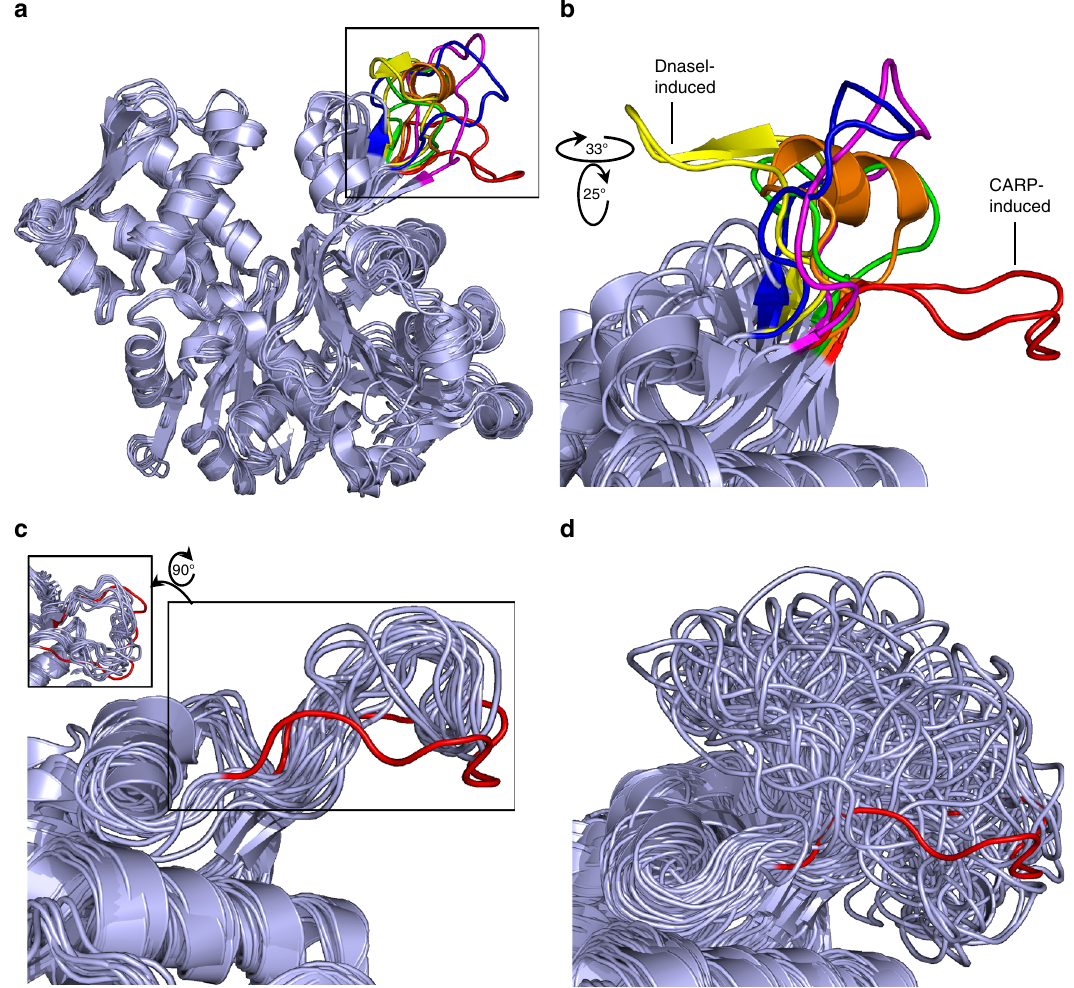
Fig. 2 The D-loop of the G-actin adopts a unique conformation induced by the CARP domain. a Superimposition of selected structures of actin where the D-loop is resolved: un-complexed ADP-actin (1j6z) 48 (orange); ADP-actin in complex with CARP domain (6fm2) (red); ATP-actin in complex with DnaseI (3w3d) 49 (yellow); ATP-actin in complex with pro fi lin (2btf) 44 (magenta); ATP-actin with cytoD (3eks) 50 (blue); ATP-actin in complex with ADF-H domain (3daw) 46 (green). The conformation of the D-loop in CARP/ADP-actin monomer complex is different from other conformations reported. PDB entries are indicated in brackets. b A rotated, zoomed in view of the actin D-loop region from the structures listed in a . c Representative subset of D-loop conformations sampled with 10 ns intervals from the atomistic MD simulations of the ADP-actin – CARP domain complex (System 1, Supplementary Table 3) demonstrate the stability of the peculiar D-loop conformation detected in the crystal structure (in red). d A representative subset of D-loop conformations sampled with 10 ns intervals from the MD simulations of ADP-actin (isolated from ADP-actin – CARP domain complex, System 4, Supplementary Table 3) shows structural fl exibility of the D-loop in the absence of the CARP